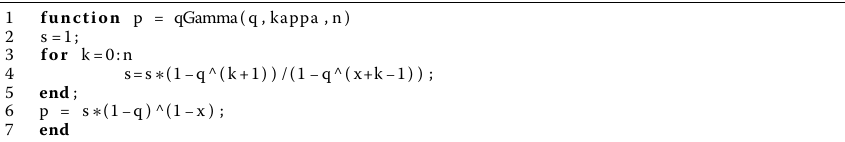
Algorithm 1 (MATLAB function for calculation q -gamma function)